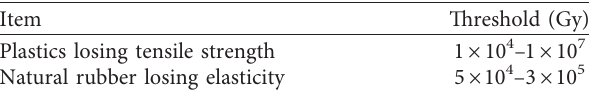
Figure 2: The geometry structure in the QAD-CGA calculation. Table 1: Two concerned radiation damage